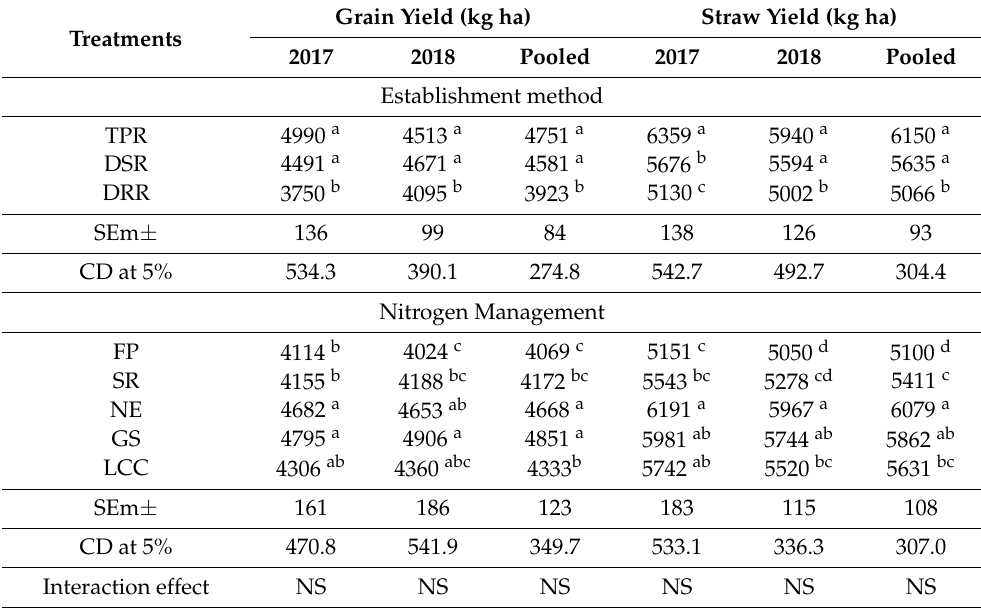
Table 6. Influence of crop establishment methods and nitrogen management on yield of “Pratikhya” Kharif rice variety.